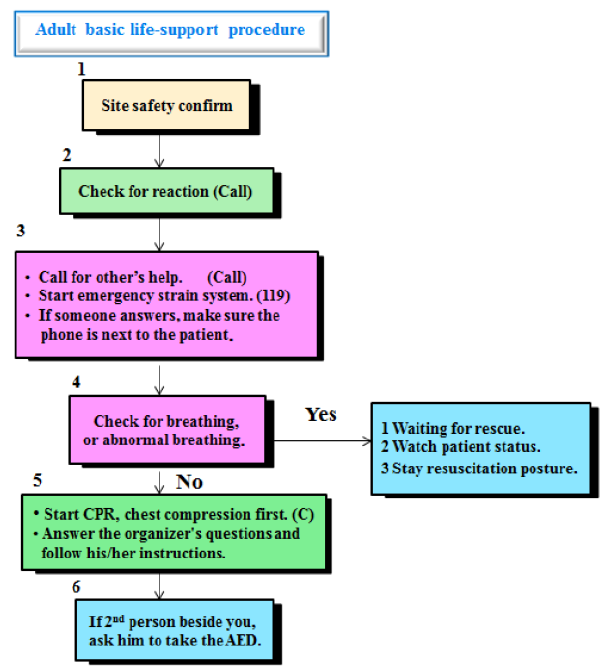
Figure 1. Summarized procedures for adult basic life support.